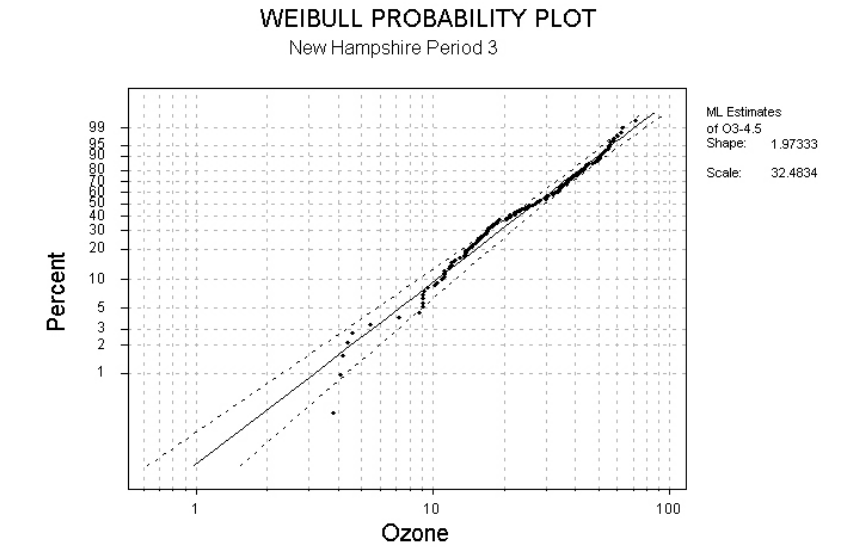
FIGURE 2. An example showing the Weibull probability distribution of the hourly O 3 concentrations (ppb) from continuous measurements during 1 week (July 19–26, 1994). The horizontal axis represents the ordered statistic of the O 3 levels. The solid line in the figure shows the expected, the solid circles show the distribution of the hourly concentrations, and the two dotted lines represent the 95% confidence intervals. The one data point outside the 95% confidence interval is within the 5% of occurrence of outlier values allowed in the